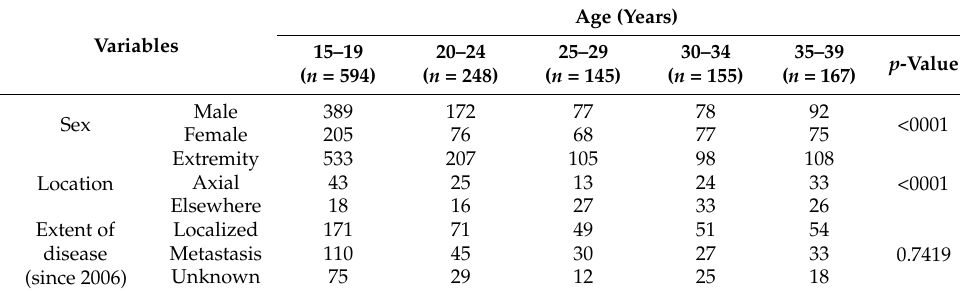
Figure 3. Overall survival of patients with osteosarcoma according to age and tumor site. ( A ) Extremity tumors, ( B ) Axial tumors. Table 4. Comparison of clinical characteristics among AYA age